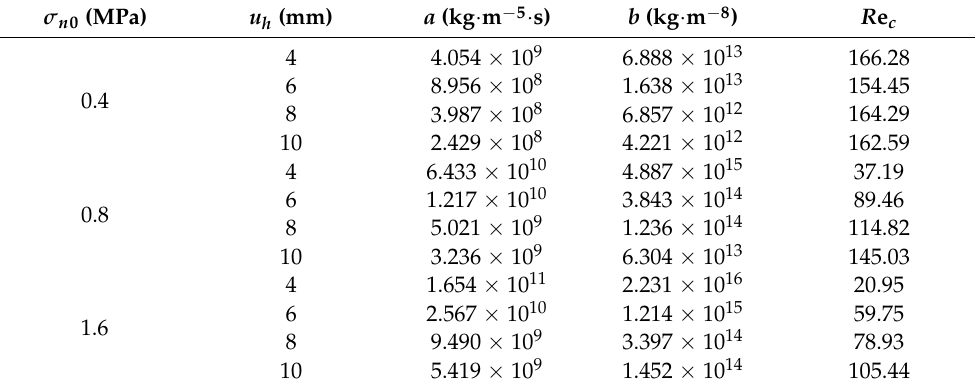
Table 2. Corresponding a , b , and R e c values of rough fractures ( H = 0.6) under different stress